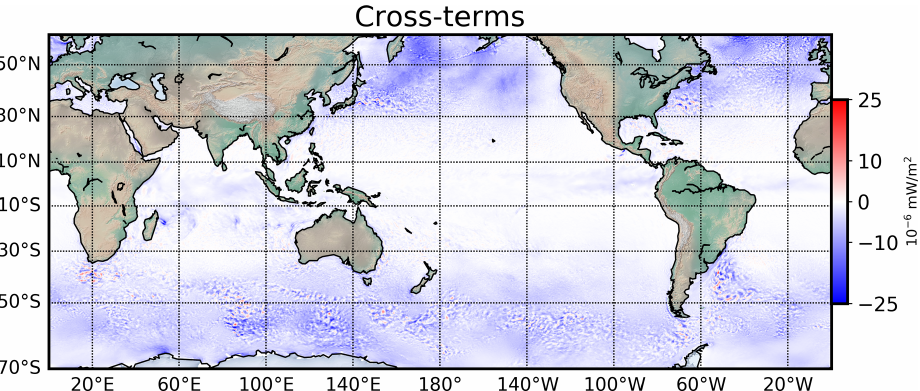
Figure 3. The cross-terms not present in Eq. (4) estimated as the differences between the left and right hand sides of this equation.